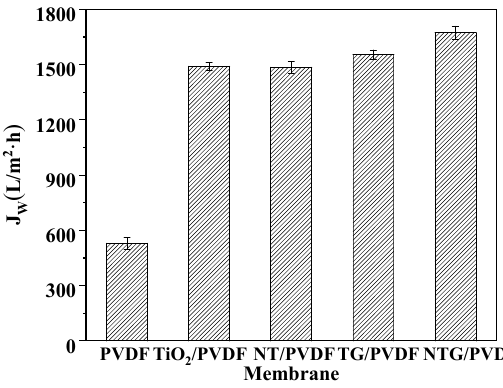
Figure 7. The pure water flux of the membrane.